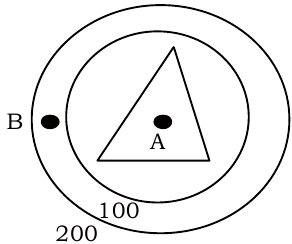
Figure 2. Deviation by minimizing labor cost Note : Circles are iso-cost curves, which show the increase of transportation cost from the lowest cost point